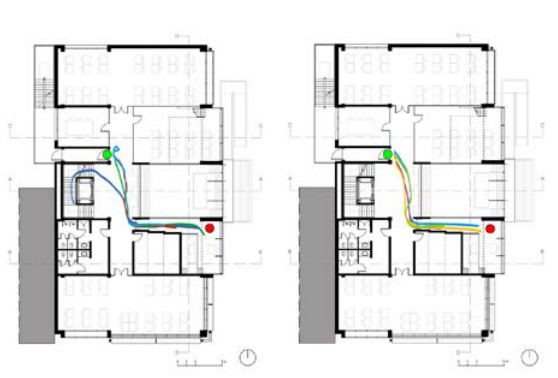
Figure 14: Path-finding for the Target 5 (emergency exit) in the refurnished building, left without signposting, right with signposting.